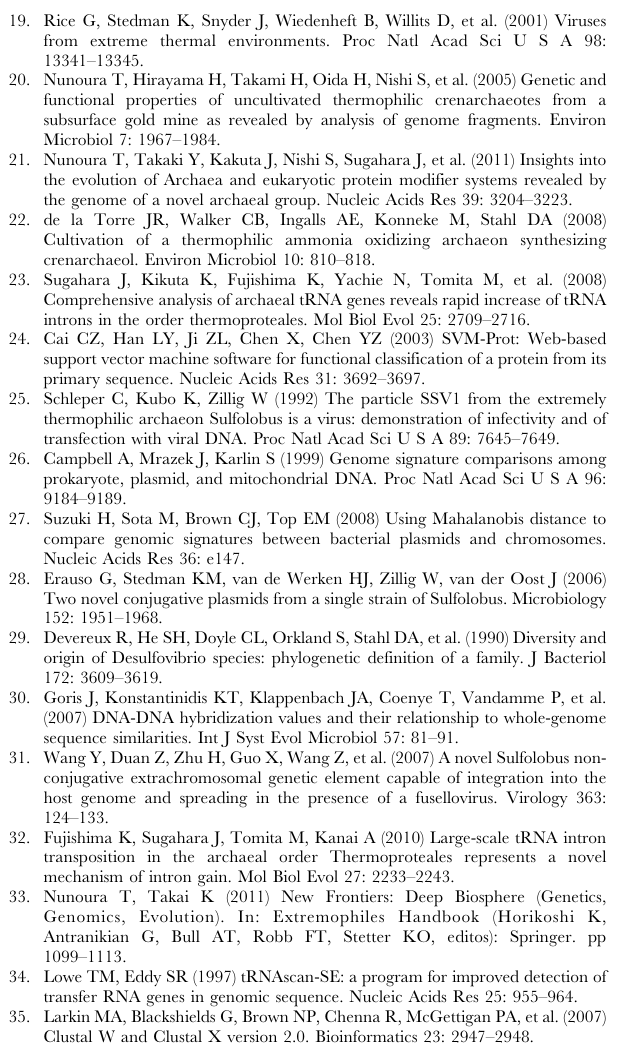
Figure 3. The gene ID for each ORF is shown in parentheses. Table S1 Independent fosmid clones reveal the genomic heterogeneity of tRNA Thr loci. (*) See Figure 2 for types of tRNA Thr . A single gene ID in a column corresponds to a full nucleotide sequence or long partial nucleotide sequence of a fosmid clone. Two gene IDs in a column correspond to 5 9 and 3 9 end nucleotide sequences of a fosmid clone, respectively.